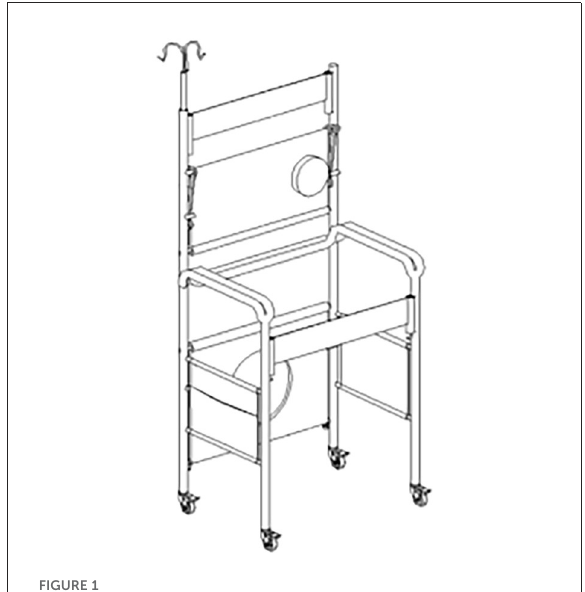
FIGURE1 Schematic diagram of the auxiliary